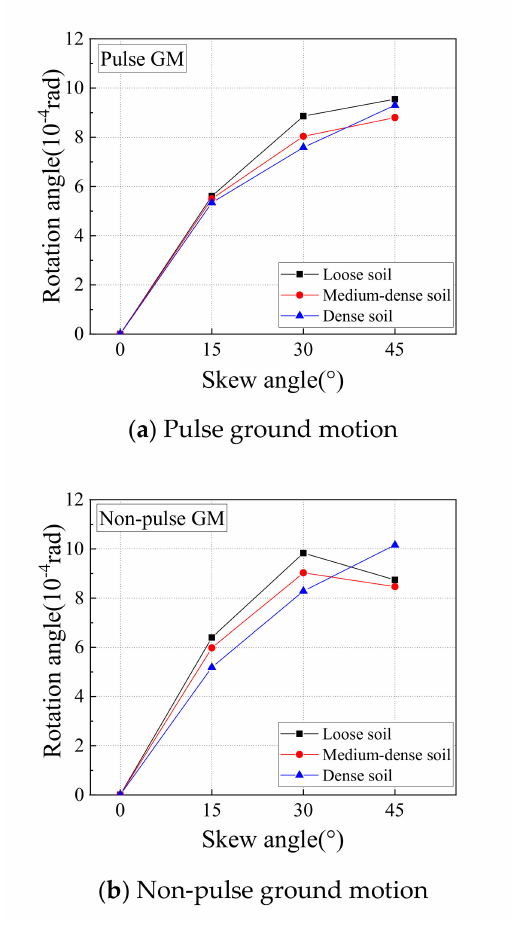
Figure 11. Maximum rotation of bridge